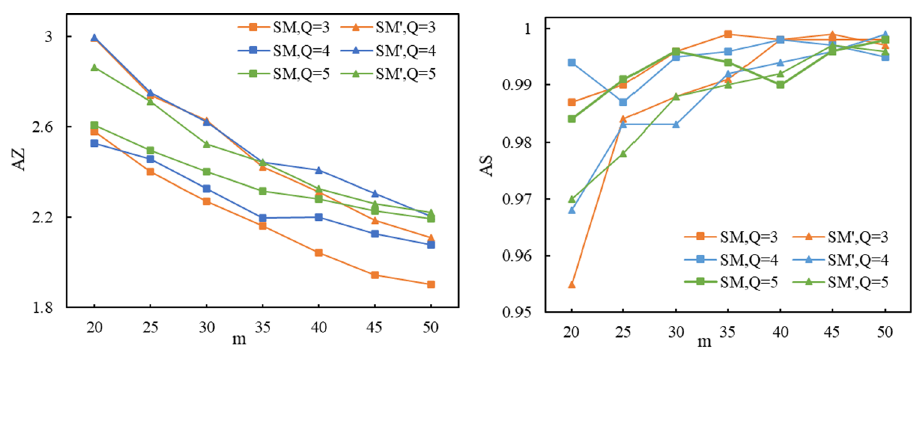
Fig. 4 AZ and AS under differ- ent parameters m and 𝛽